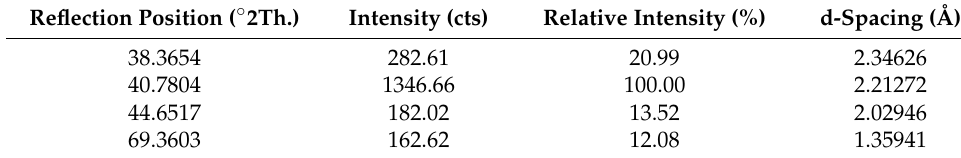
Figure 1. ( a ) SEM micrograph of powder as-atomized with a class size of 20–90 µ m; ( b ) Photography of LPBF-processes samples, where the sample taken for further analysis is indicated; ( c ) embedded as-cast sample; ( d ) X-ray diffractograms of LPBF, powder, and cast samples. SEM: scanning electron microscopy. LPBF: laser powder bed fusion. Table 2. Bragg-peaks characteristic values detected for the LPBF